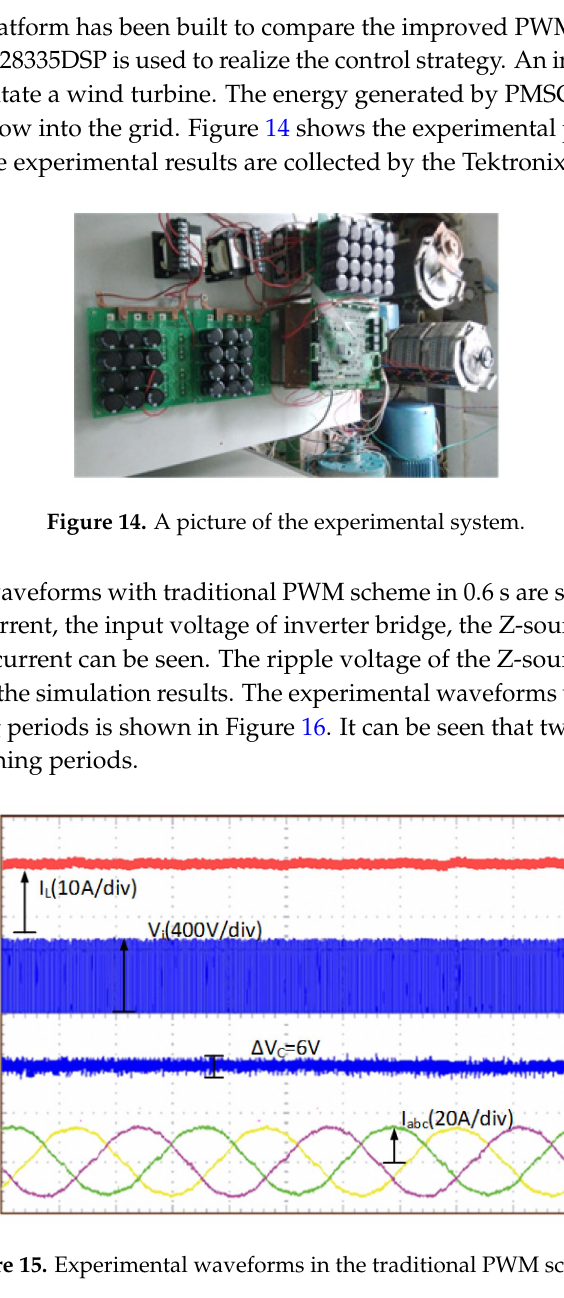
Figure 13. Amplified waveforms of the input voltage of the inverter bridge and the Z-source capacitor voltage corresponding to Figure 12.